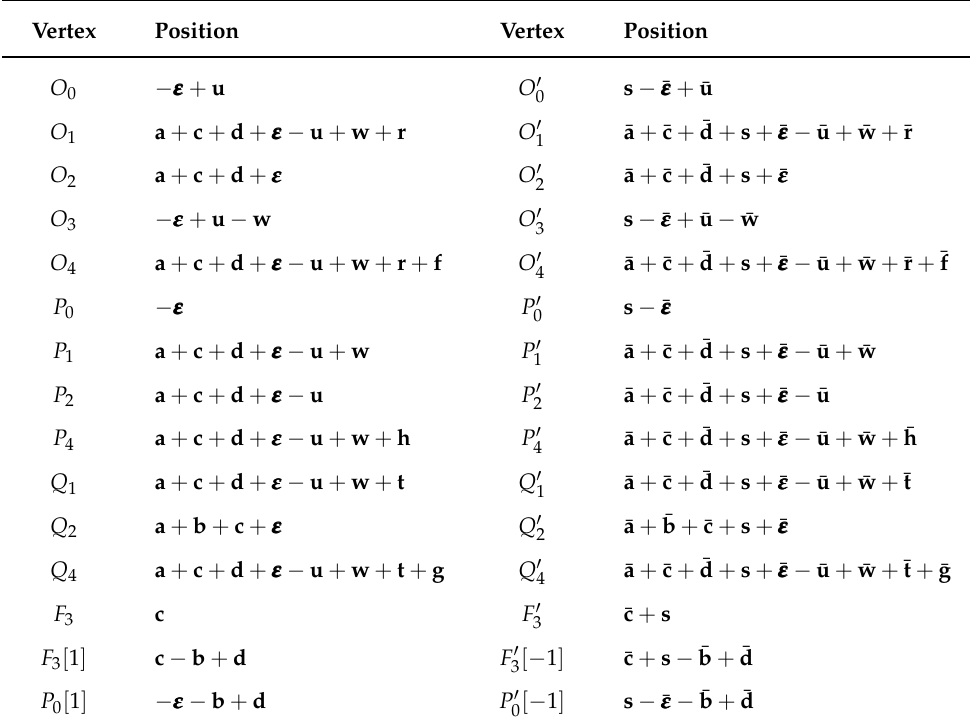
Table A2. Defining the vertices in Miura-ori inspired smooth sheet attachments for a pair of asym- metric zipper-coupled tubes. Vertex Position O 0 − εεε +